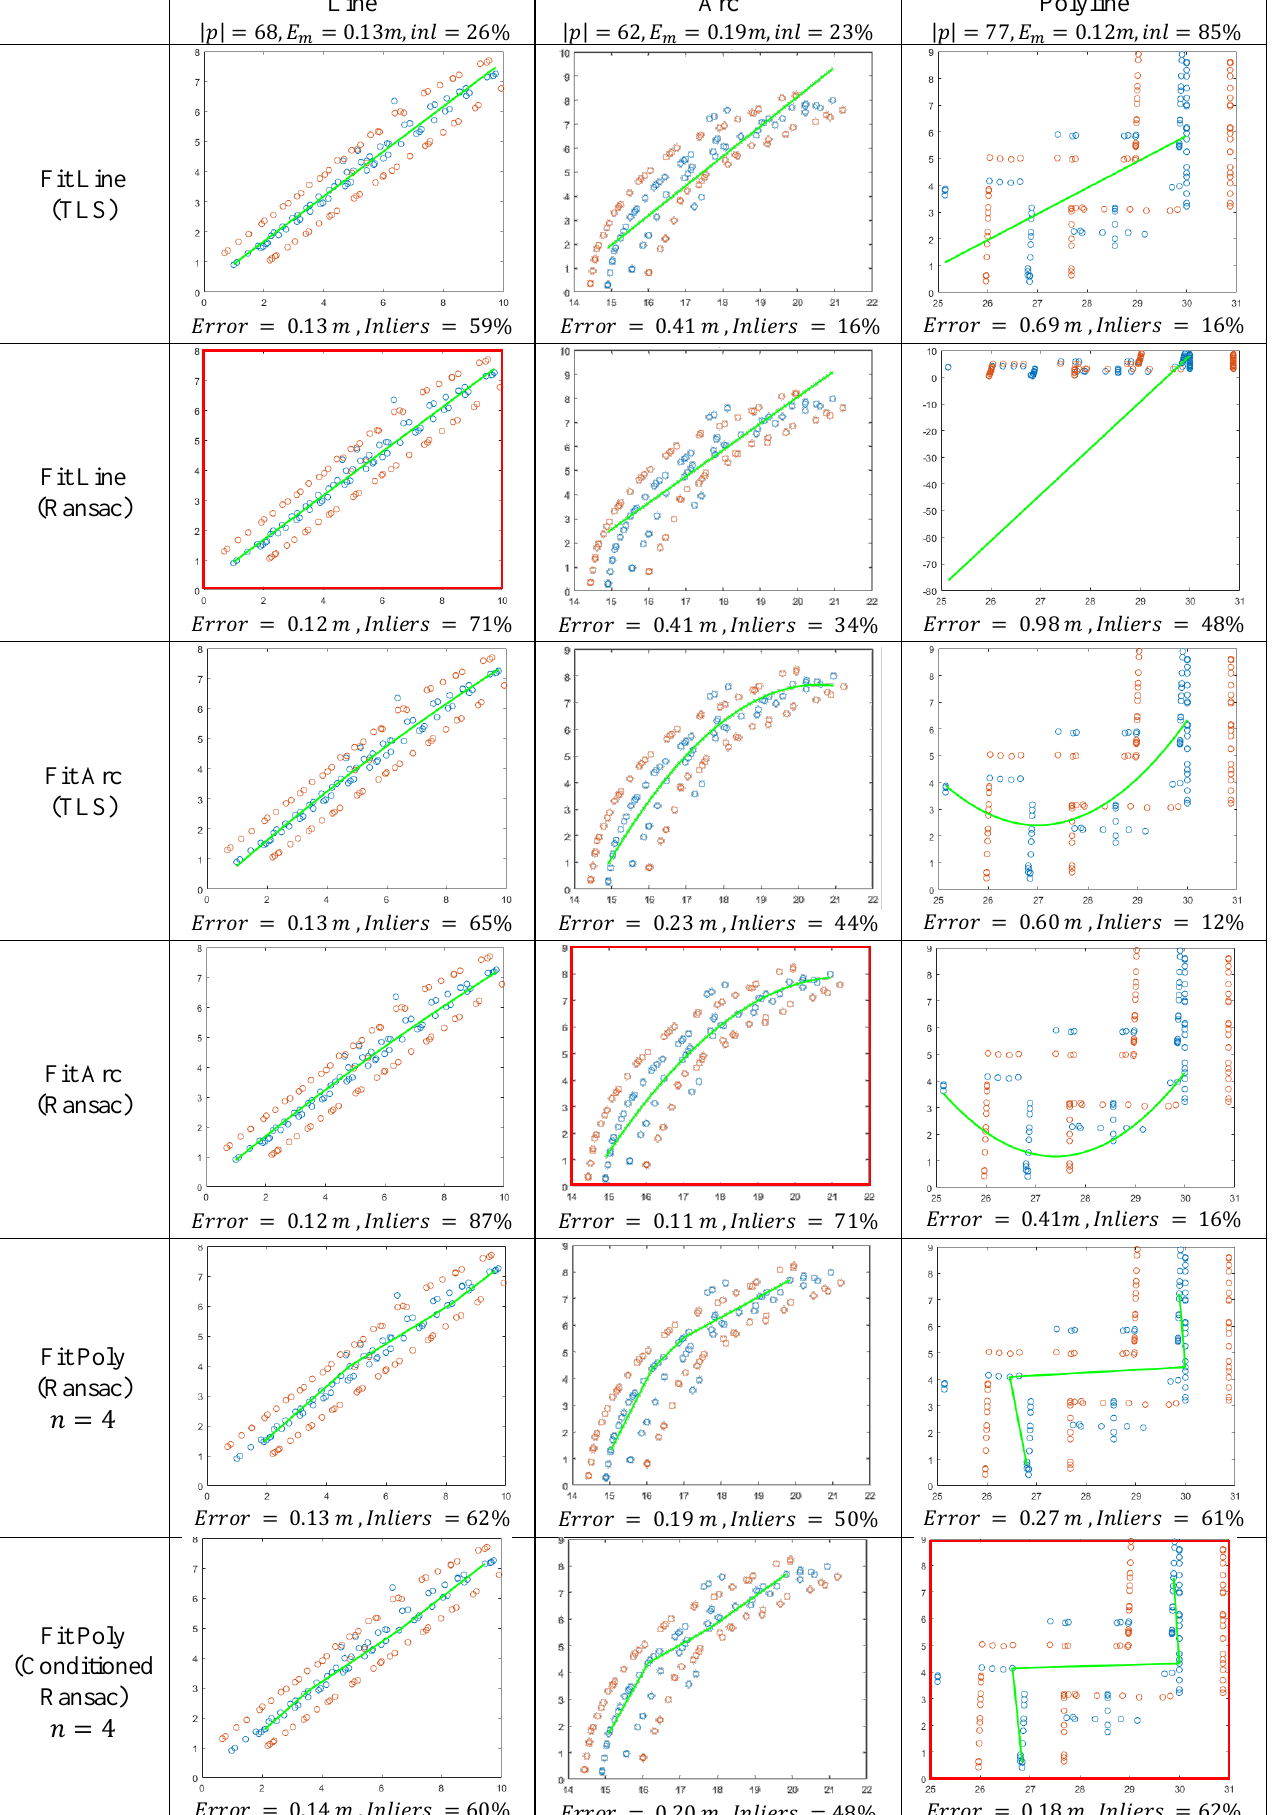
Table 1: Result of the automated hearthline reconstruction. Each column represents the fitting results for the Line, Arc and Polyline. The orange dots are P, the blue dots are C and the green lines are the computed hearthline given the different methods. The red rectangle depicts the first model to fulfill the expected error and inlier